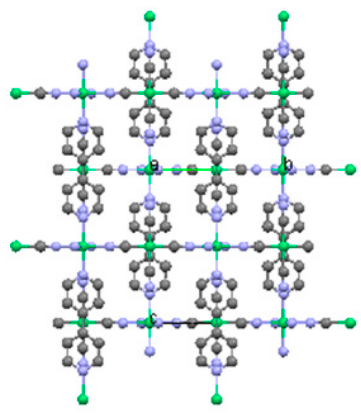
Figure 17. 2-D structure of Ni-Bpy along a -axis, with sheet-like structure spreading in the bc direction (C-grey, N-blue, Ni-green).